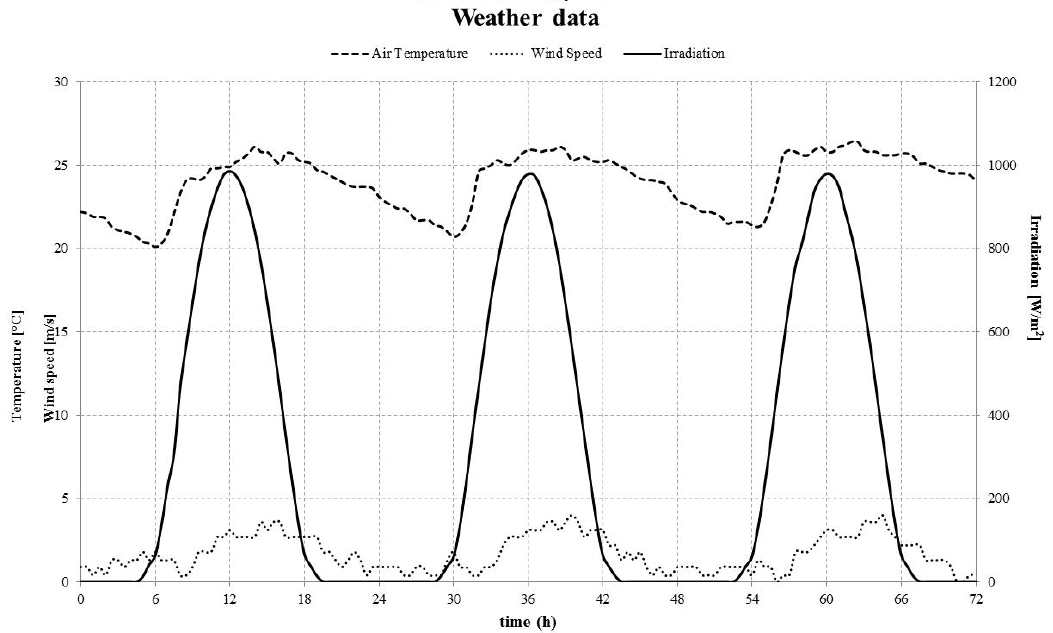
Figure 10. Trends of weather parameters in Palermo, 30 June–2 July